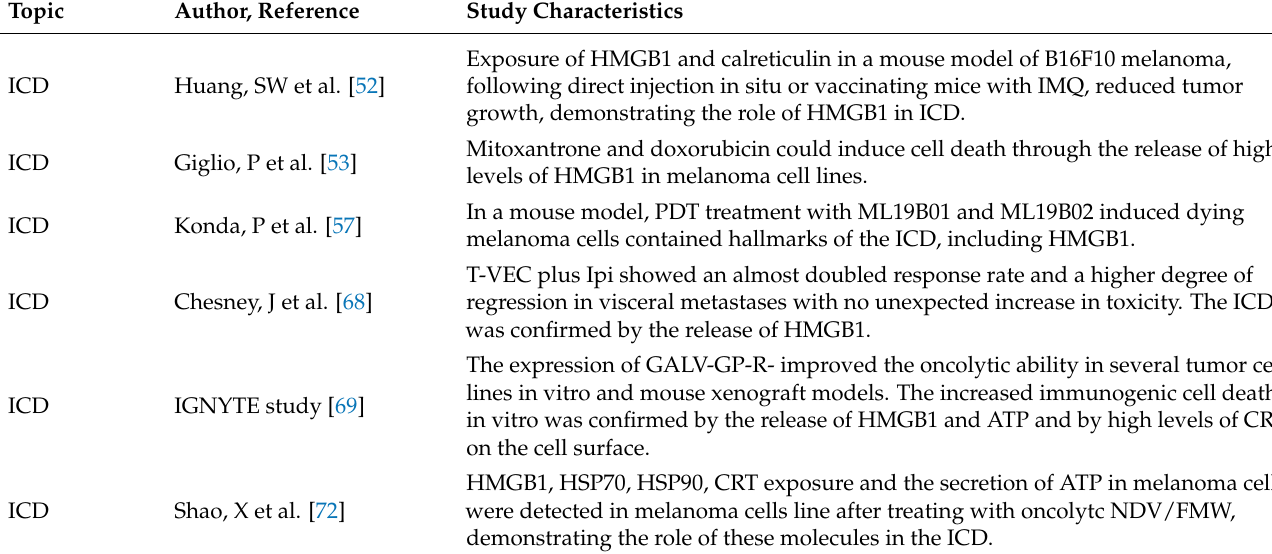
Table 2. The main findings about the role of HMGB1 in the development of ICD in melanoma and its possible use as a novel therapeutic